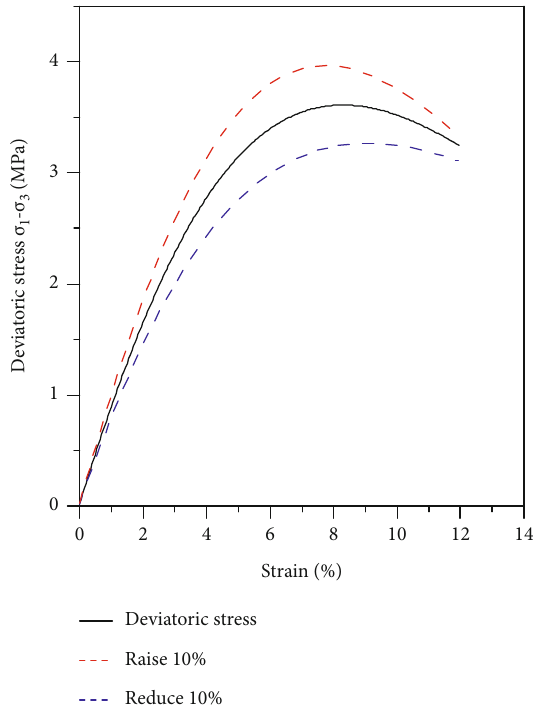
Figure 9: Comparison of the in fl uence of a 10% increase or decrease in multiple model parameters on the calculation curve (frozen